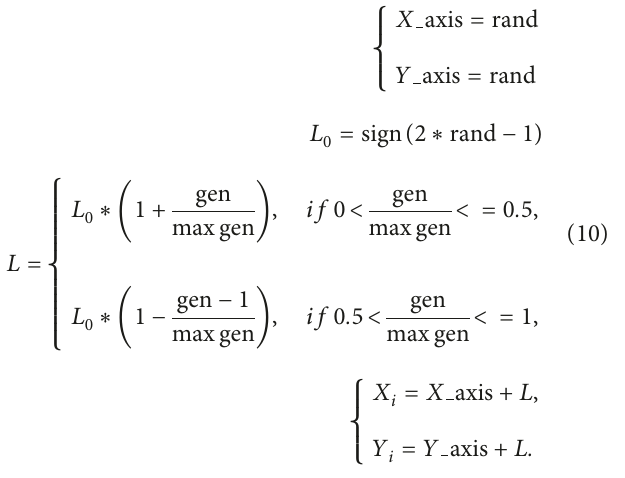
Figure 3: IFOA-GRNN algorithm flow